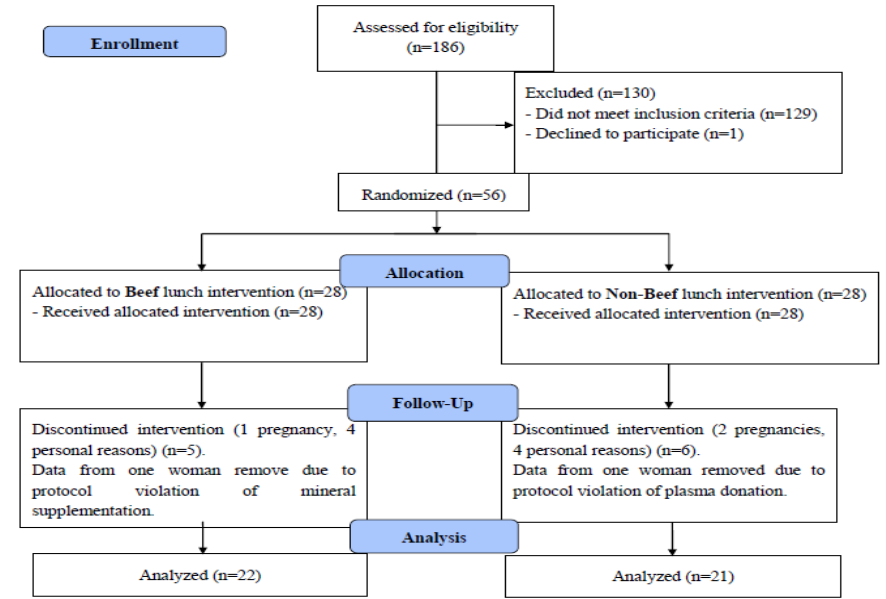
Figure 1. Volunteer flow